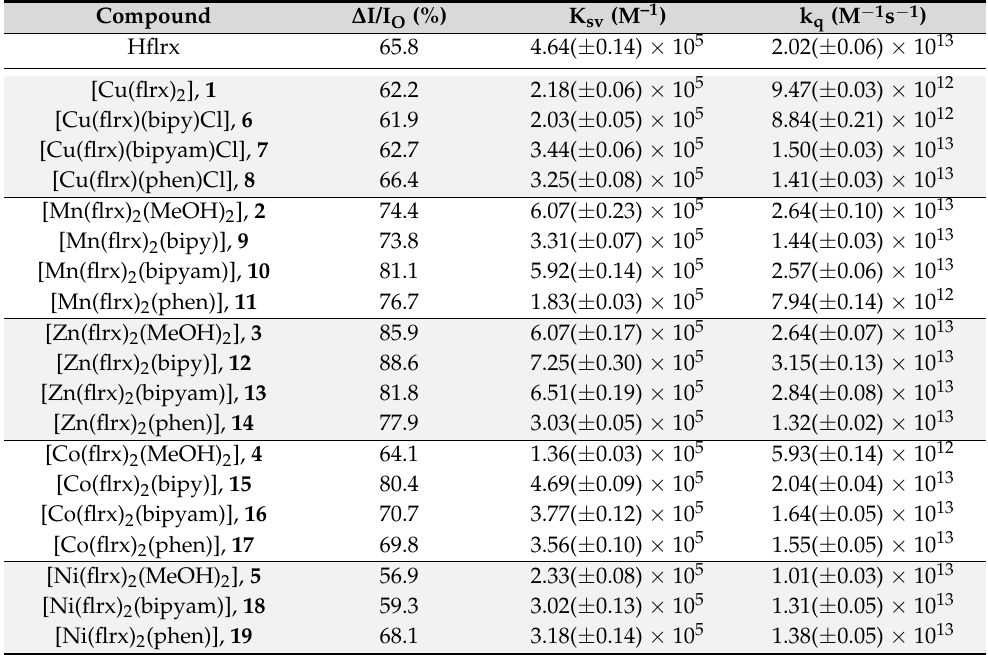
Figure 8. Fluorescence emission spectra ( λ exc = 540 nm) with a buffer solution (150 mM NaCl and 15 mM trisodium citrate at pH = 7.0) containing an EB–DNA adduct ([EB] = 20 µ M, [DNA] = 26 µ M) in the absence and in the presence of increasing amounts (up to r = 0.12) of [Zn(flrx) 2 (bipy)]. The arrow shows the changes in intensity upon increasing amounts of the complex. Table 8. Percentage of EB–DNA fluorescence quenching ( ∆ I/Io, in %), Stern–Volmer constant (K SV , in M − 1 ) and the quenching constant (k q , in M − 1 s − 1 ) for fleroxacin and its complexes 1 – 19